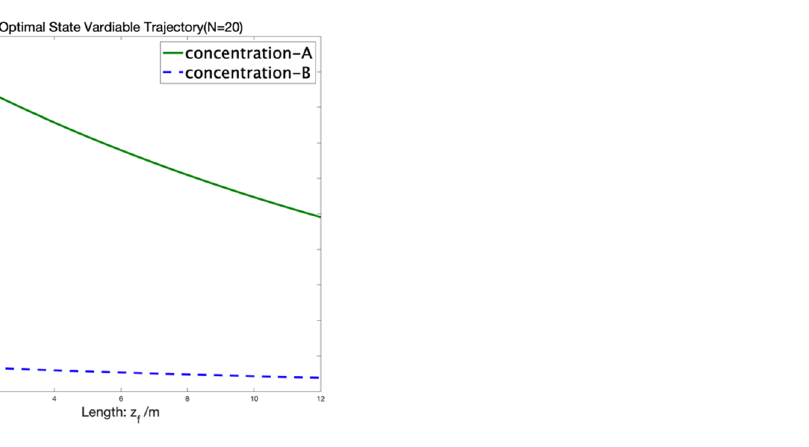
Figure 30. Optimal control trajectory and iteration curve ( 20 N = ).